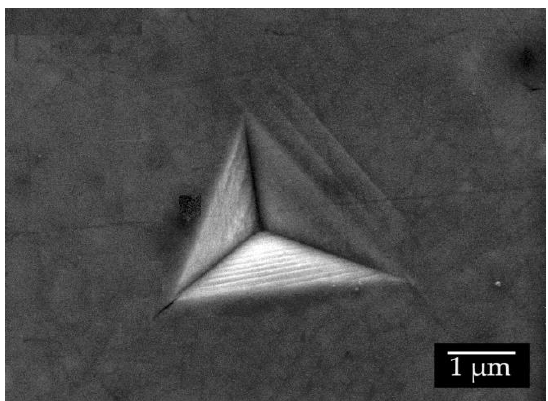
Figure 12. Steps and slip lines near indent in the FeB phase in the microstructure of alloy 50 Fe–40 B–10 Cr.